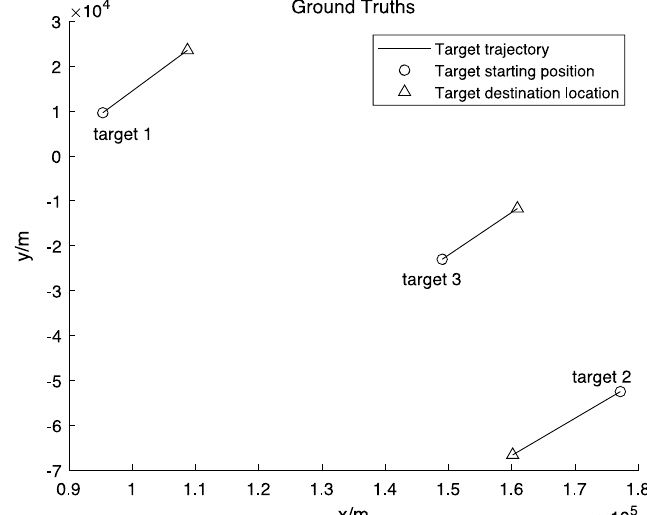
Fig. 5 True trajectories of 3 targets on the 2D